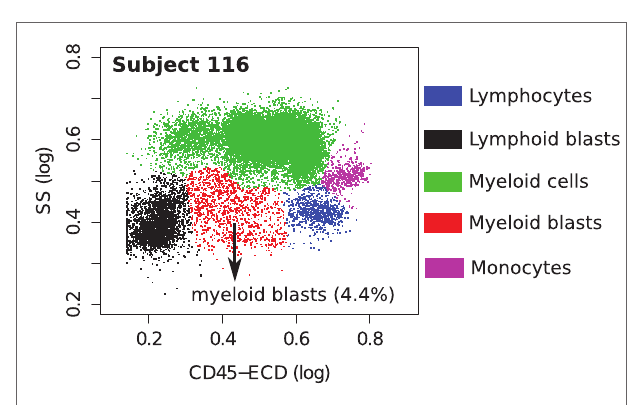
FigUre 15 | cell populations in a samples from subject 116 . This sample contains only 4.4% myeloid blast cells (shown in red).